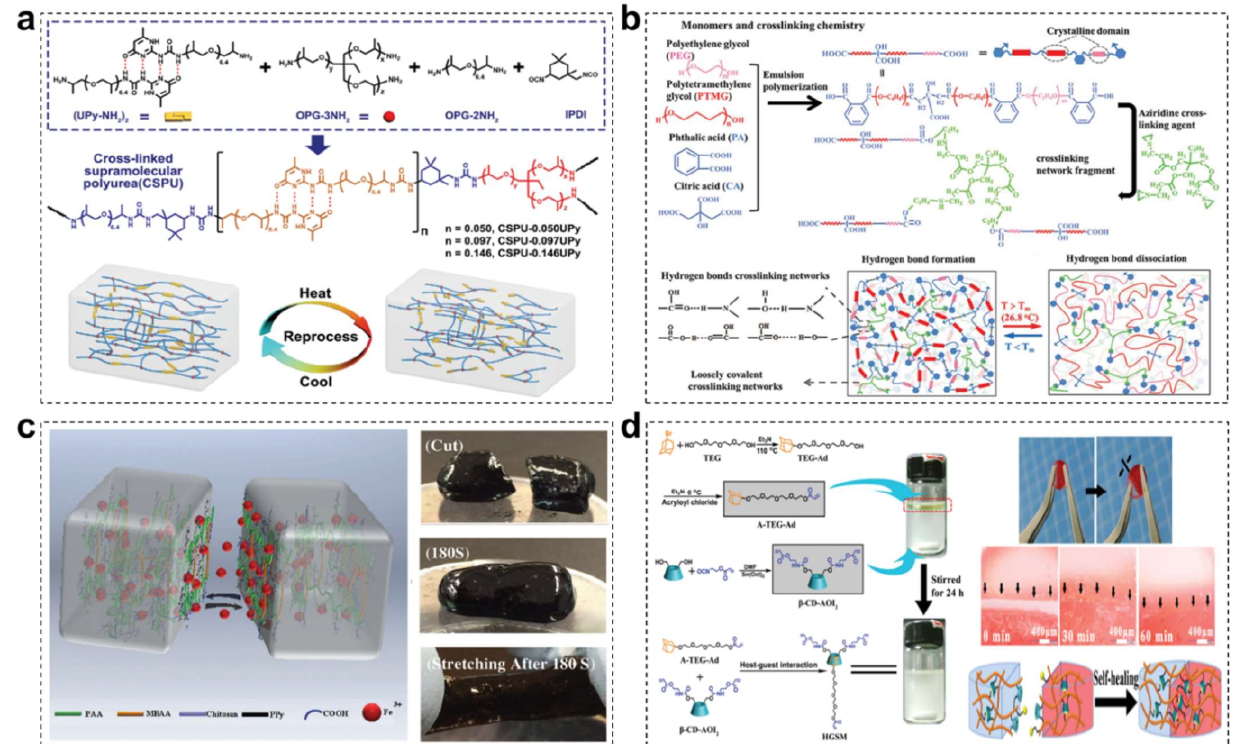
Figure 6. ( a ) The synthesis of supramolecular polyureas and chemical structures of the designed noncovalently bonded diamine monomers, covalent diamine/triamine monomers and diisocyanate monomers. Schematic diagram of the recycling process of the resultant polyureas based on the covalent-noncovalent crosslinking strategy [162]. Copyright 2020, Wiley-VCH. ( b ) The monomers, prepolymers and crosslinking agents used in the synthesis of copolyester, and a schematic network fragment of the copolyester. Schematics of the network structure before and after crystallization- melting transition. Reproduced with permission [163]. Copyright 2019, Wiley-VCH. ( c ) Schematic healing mechanism of the resultant hydrogel physical and chemical crosslinking networks. Digital pictures during cut, healing for 180 s and stretching after healing. Reproduced with permission [167]. Copyright 2017, Wiley-VCH. ( d ) Schematic synthesis procedures of self-healing hydrogels with dynamic host-guest noncovalent crosslinking network and covalently linked network design.